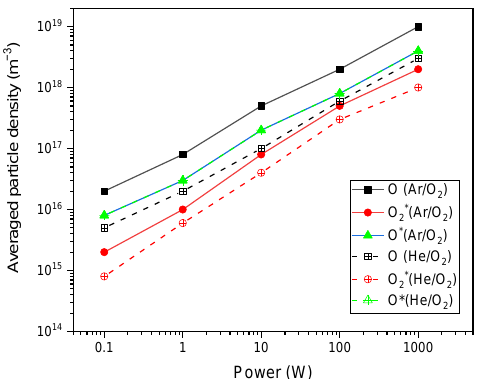
Figure 14. Variations of average particles densities of He/O 2 and Ar/O 2 with power (P = 0.3 Torr, f = 13.56 MHz). (*) Excited state of atoms.